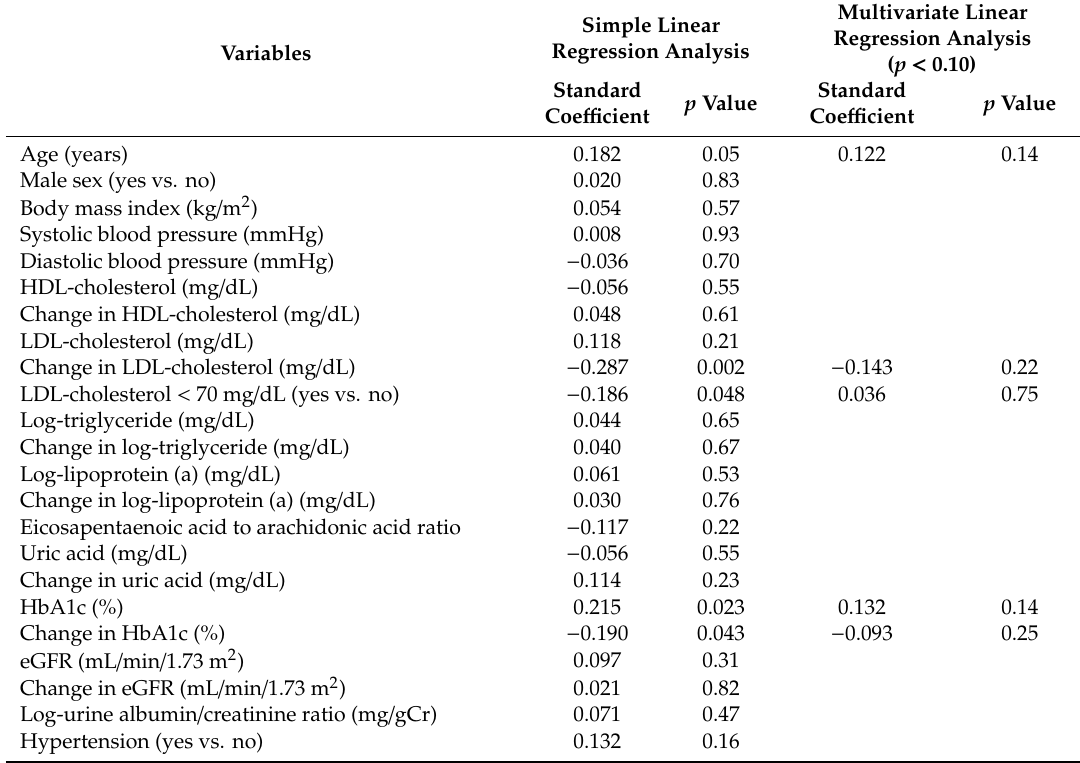
Table 4. Simple and multiple linear regression analyses of variables associated with the change in size (evaluated by remodeling index) of vulnerable coronary plaques during the administration of